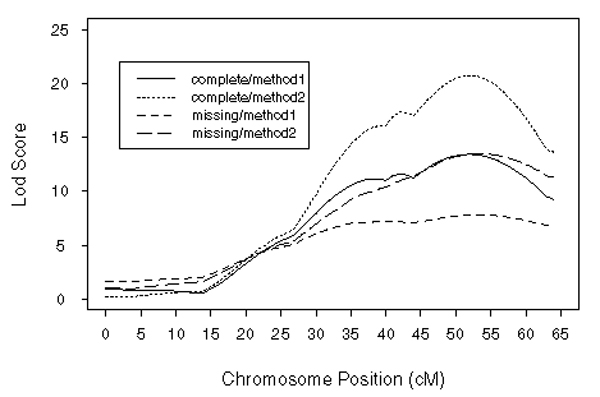
Multipoint LOD score profiles for chromosome 21 in the complete and missing simulated data sets, using Method 1 and Method 2